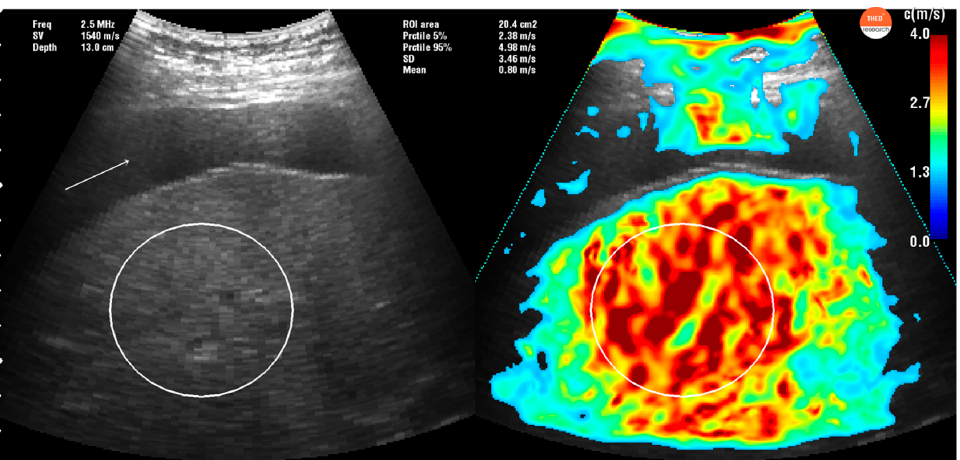
Figure 6. Liver stiffness measurement obtained with THE in a cirrhotic patient with ascites (white arrow). In this picture, we can see the acquisition of the LSM (in the right side of the figure) reflecting cirrhotic liver in orange-red. We can depict the orange-red appearance of the cirrhotic liver even if ascites is present. The current ROI has an area of 20.4 cm 2 with a corresponding LS (mean ± SD, (5% percentile, 95% percentile)) of shear wave speed = 3.46 m/s ± 0.80 m/s (2.38 m/s, 4.98 m/s) and Youngs modulus = 35.91 kPa ± 16.61 kPa (16.99 kPa, 74.40 kPa) respectively.